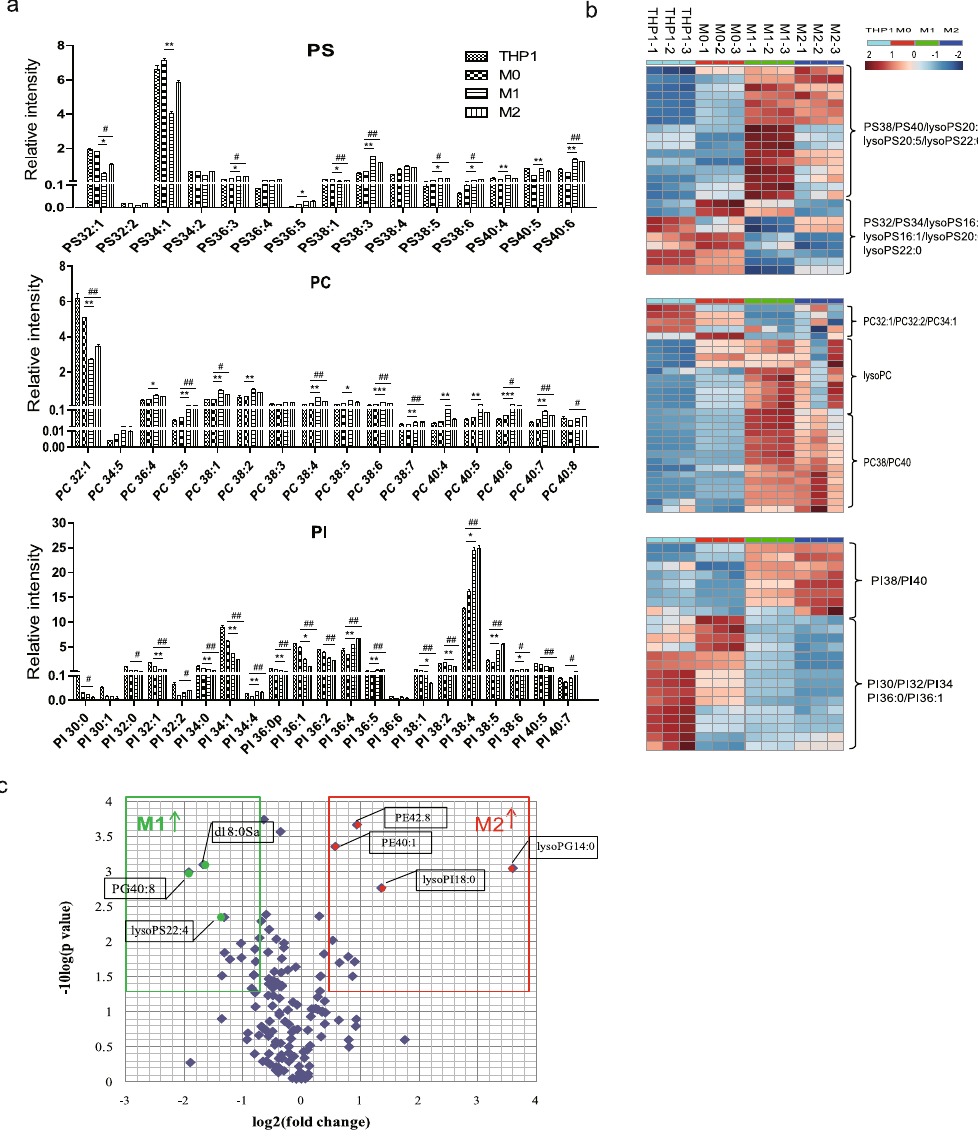
Figure 3. Activated macrophages derived from human monocytic THP-1 cells show the accumulation of medium- and long-chain polyunsaturated lipids ( a,b ) Histogram (a) and clustering analysis (b) indicated that during macrophage differentiation, long-chain and polyunsaturated lipids (PS38:3, PS38:5, PS40:6, PC40:6, and PI38:4, etc.) accumulated in the activated macrophages. In contrast, saturated and monounsaturated lipids with fewer carbons (PS32:1, PC32:1, PI30:0, PI34:1, and PI36:1, etc.) were elevated in THP-1 and M0 cells ( * represents comparisons between M1 and M0, # represents comparisons between M2 and M0). ( c ) Volcano plots show that lipids were differentially expressed between M1 and M2 macrophages. The x-axis shows the log2-fold change (fold change = intensity of M2 to M1). The y-axis shows the -log10 p-value for the corresponding lipids. The top lipids that are elevated in M1 cells are highlighted in green, and those that are elevated in M2 cells are indicated by red dots (fold change > 1.5 or < 0.67, p <